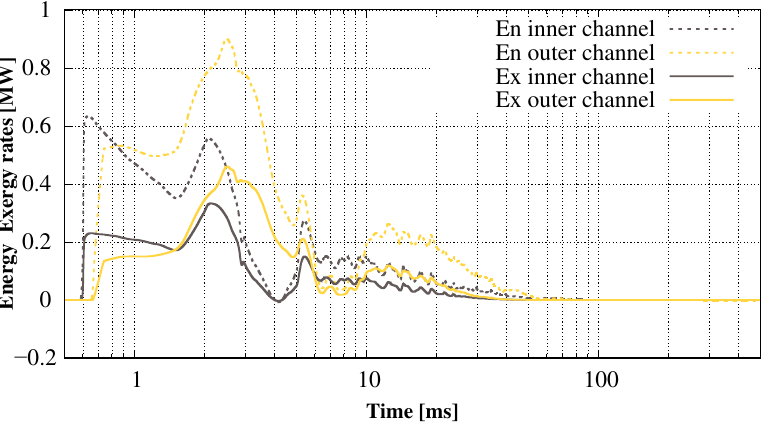
Figure 19. Outlet energy and exergy according to channel.